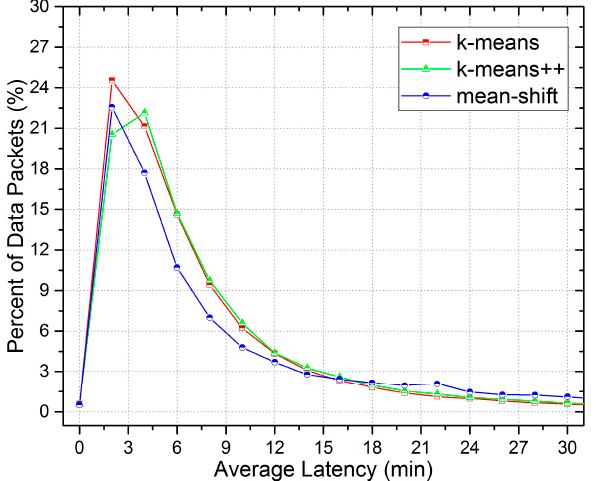
Figure 9. Distribution based on the latency of uploaded data packets.